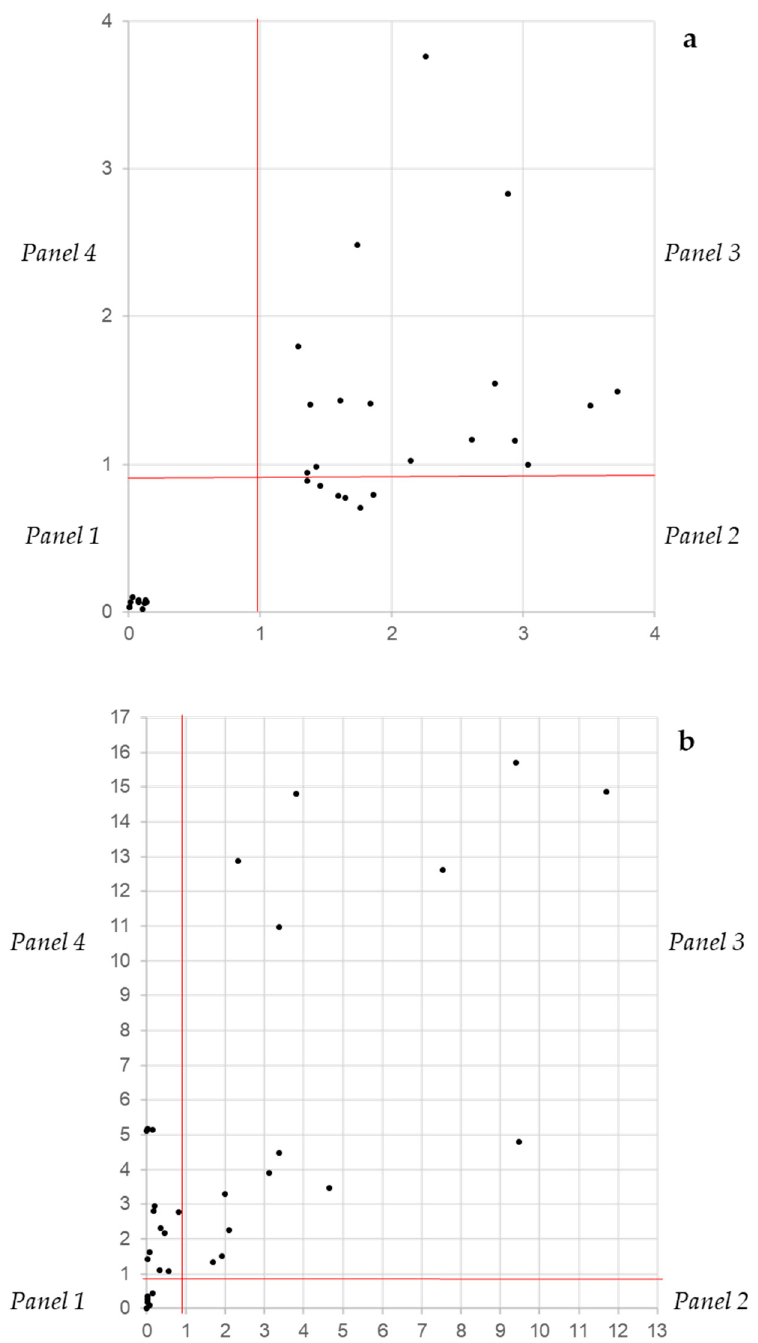
Figure 5. The distribution on a bidimensional space of Candida ( a ) and Staphylococcus ( b ) strains according to their XTT N and CV N values. Panel 1: No biofilm production, panel 2: biomass production and low biofilm activity, panel 3: biomass production and high biofilm activity and panel 4: low biomass production and low biofilm activity.